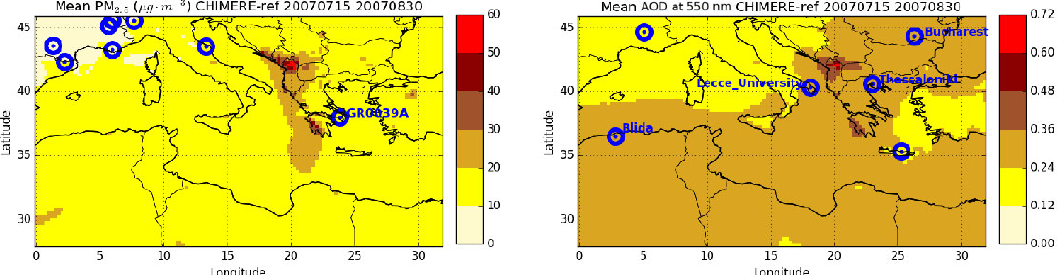
Figure B1. Daily mean surface PM 2 . 5 and AOD at 550nm from the CHIMERE-ref simulation averaged over the summer of 2007 (the eight AIRBASE and six AERONET stations, used in this work, are represented here by blue